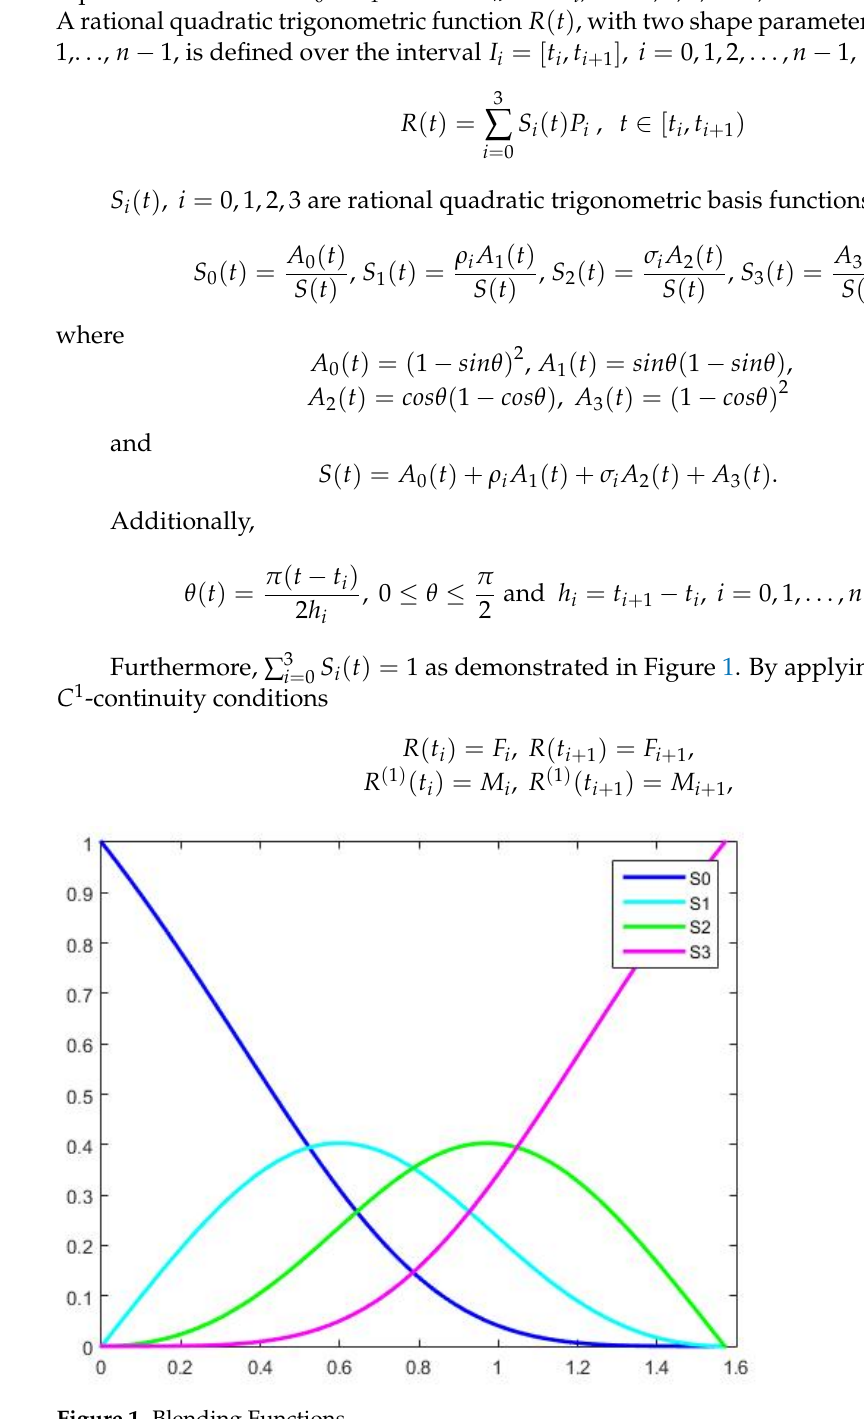
Figure 1. Blending Functions.